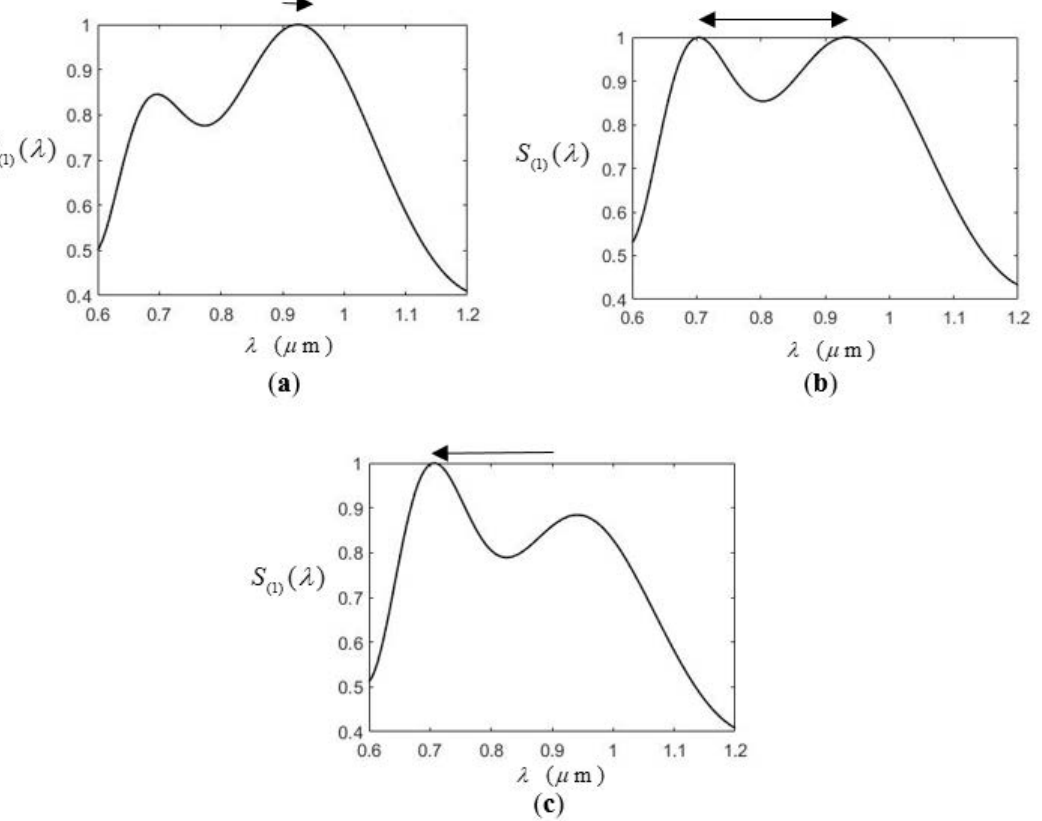
Figure7. Thespectralswitchof S ( 1 ) ( λ , x ) atthreelocationswith z = 0.1 µ m: ( a ) x = 0.57 µ m; ( b ) x = 0.604 µ m; and ( c ) x = 0.63 µ m. The spectrum maximums used to normalize S ( 1 ) ( λ , x ) are 1.35, 1.26, and 1.34 in ( a – c ),